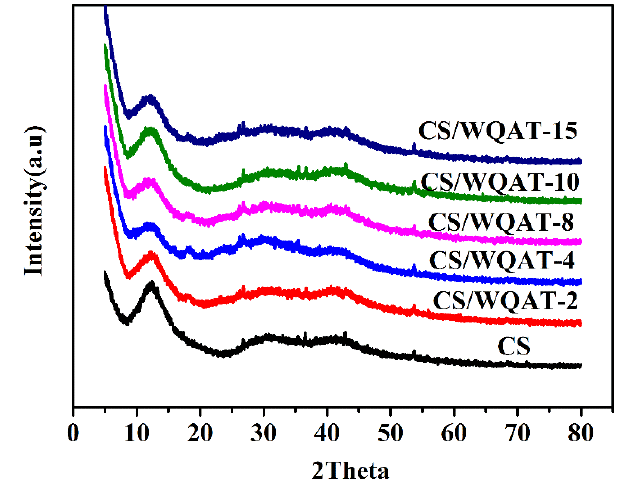
Figure 4. Comparison of XRD patterns of CS and CS / WQAT composite membranes.